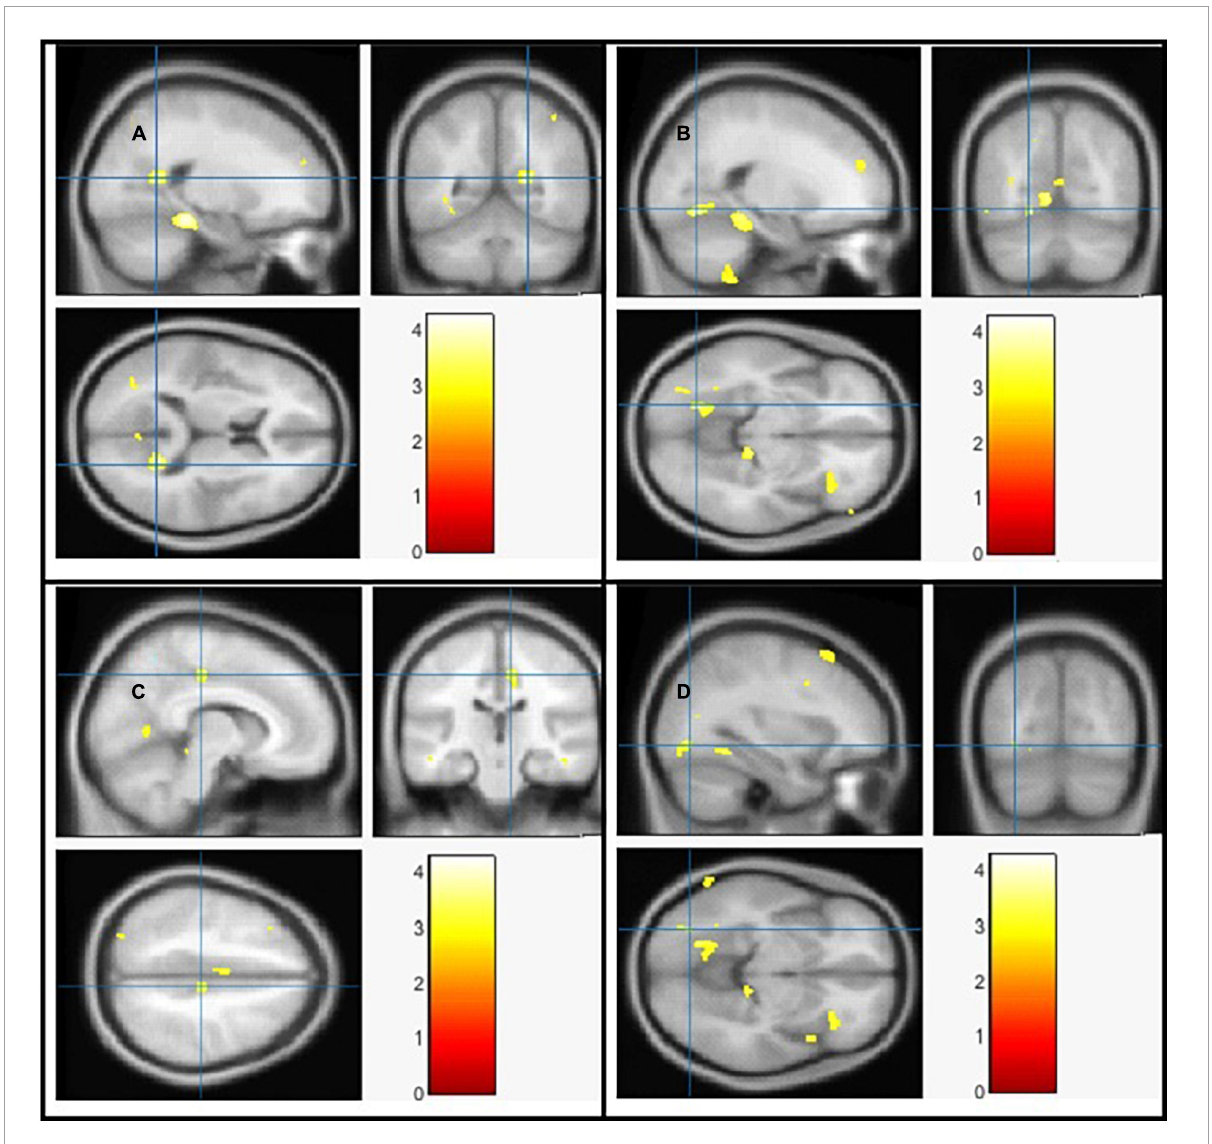
FIGURE3 The significant white matter (WM) alterations by VBM analyses with the covariate of no interest (TIV) in the right calcarine (A) , left lingual gyrus (B) , right middle cingulate (C) , and left inferior occipital gyrus (D) , respectively when PD < controls with p < 0.05 and extent threshold K = 100.